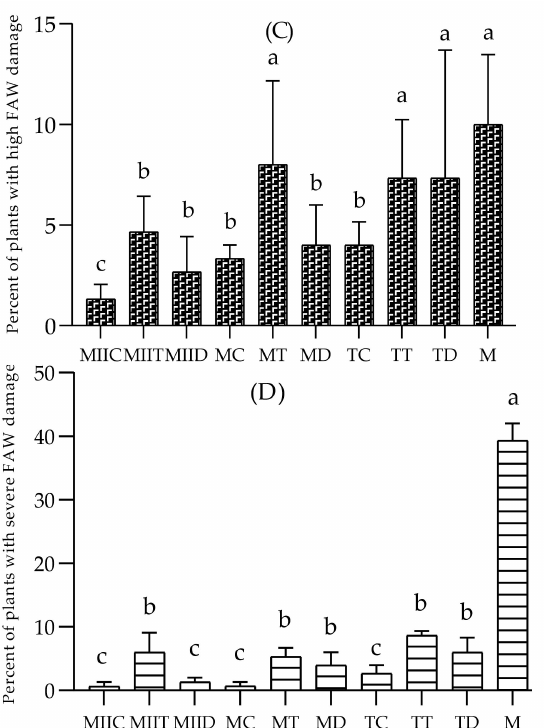
Figure 6. Severity of S . frugiperda in maize crops in the evaluated systems. Percent of plants with Fall Armyworm Low damage ( A ), Medium damage ( B ), High damage ( C ) and Severe damage ( D ). Different letters indicate a significant difference by the Scott–Knott test ( α = 0.05). For abbreviations, see Table 1.